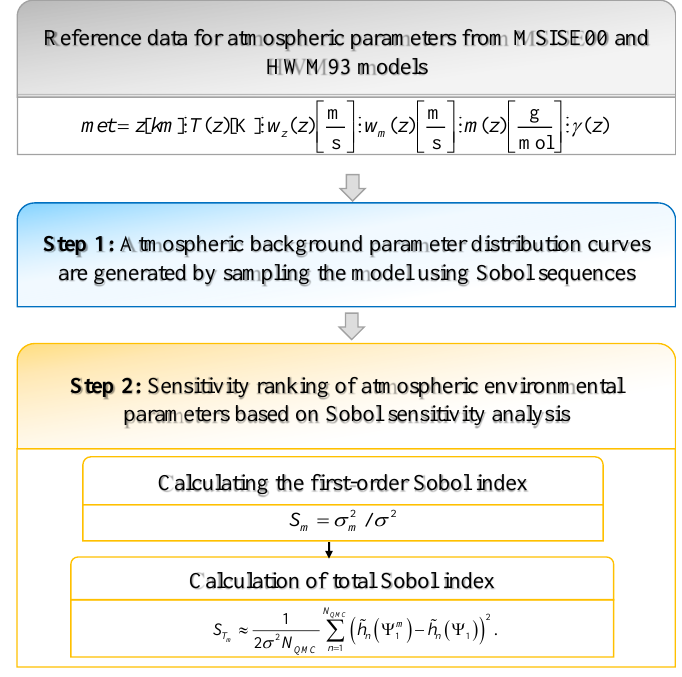
Figure 4. In the first step, the reference data of the atmospheric background parameters with height distribution are obtained from the MSISE00 and HWM93 models. In the second step, the distribution curves of atmospheric background parameters are generated based on the Sobol series sampling of the reference data. In the third step, the sensitivity analysis of atmospheric background parameters is performed using Sobol sensitivity analysis, and the first-order sensitivity index and total Sobol index corresponding to each atmospheric background parameter are